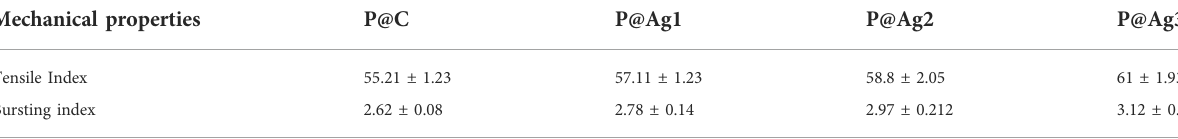
TABLE 8 Tensile and bursting properties of the control and coated kraft papers. Results are shown here in Mean± standard deviations.